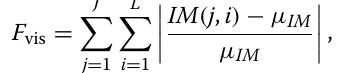
and intensity represents the pixel value, which can be